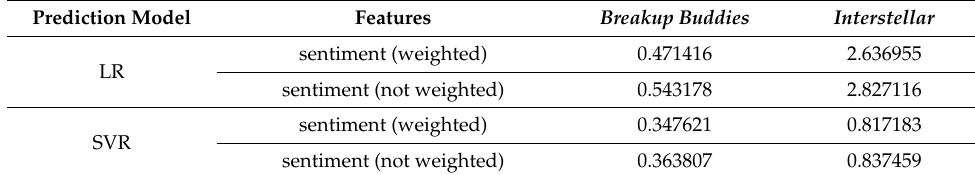
Table 5. MAPE with the sentiment feature.